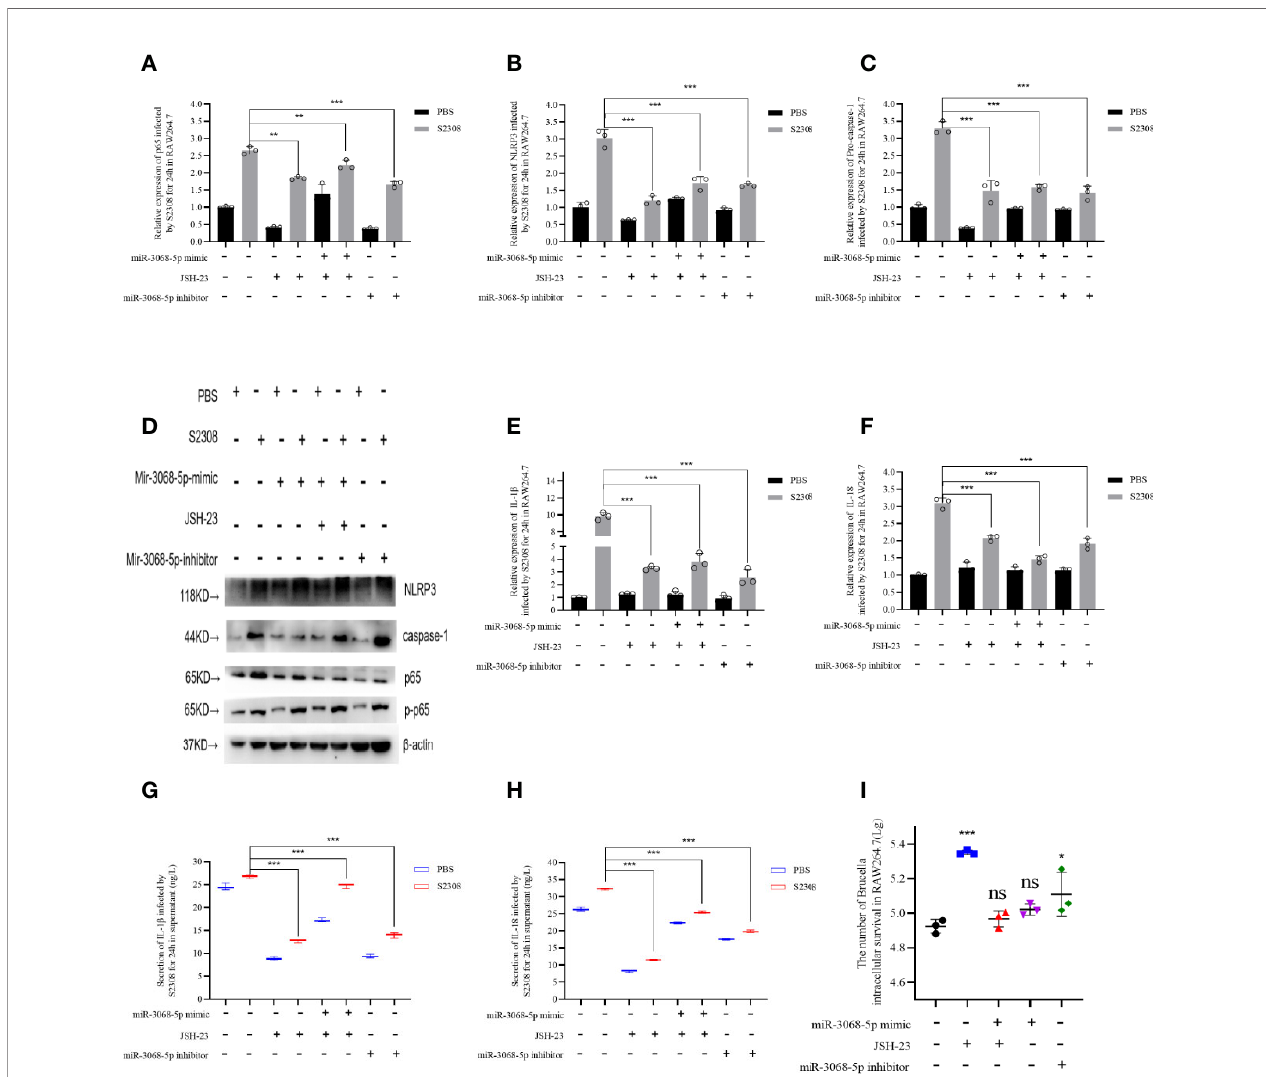
FIGURE 6 | Brucella activated NLRP3 in fl ammasome by Gm28309 – miR3068-5p – NF- k B regulatory axis in vitro . (A – E) Expression levels of p65, NLRP3 in fl ammasome, IL-1 b , and IL-18 in RAW264.7 cells transfected with either a miR-3068 inhibitor or its mimic, with or without the speci fi c p65 inhibitor JSH-23, as determined using qRT-PCR. (F , G) detection of IL-1 b and IL-18 from supernatants of the cell treated as in (A – E) , as detected using ELISA. (H) NLRP3 in fl ammasome and p65 protein levels, as detected using western blot. (I) The number of Brucella intracellular survivors. Data are shown as mean ± SD (n = 3). *p < 0.05, **p < 0.01,***p < 0.001, one-tailed t-test. ns, not signi fi